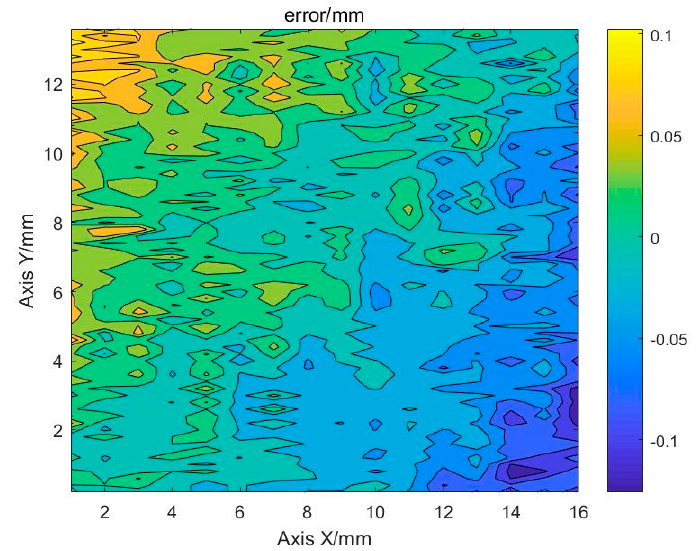
Figure 16. Flatness error of the standard block upper surface.